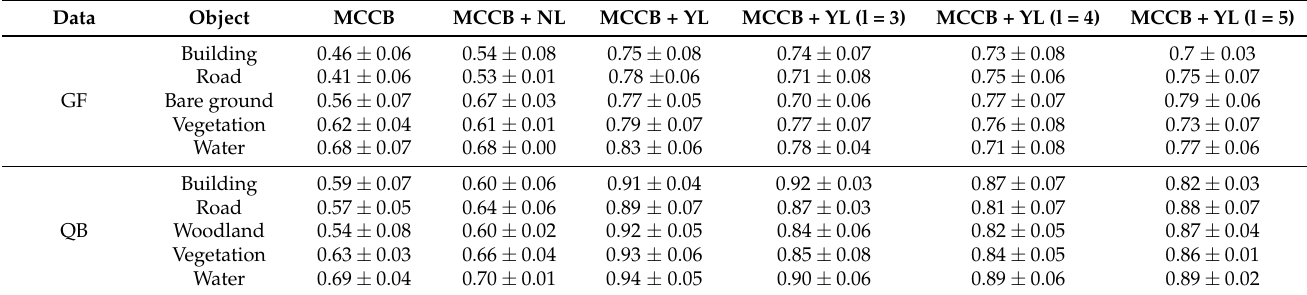
Table 6. Ablation study classification results on GF and